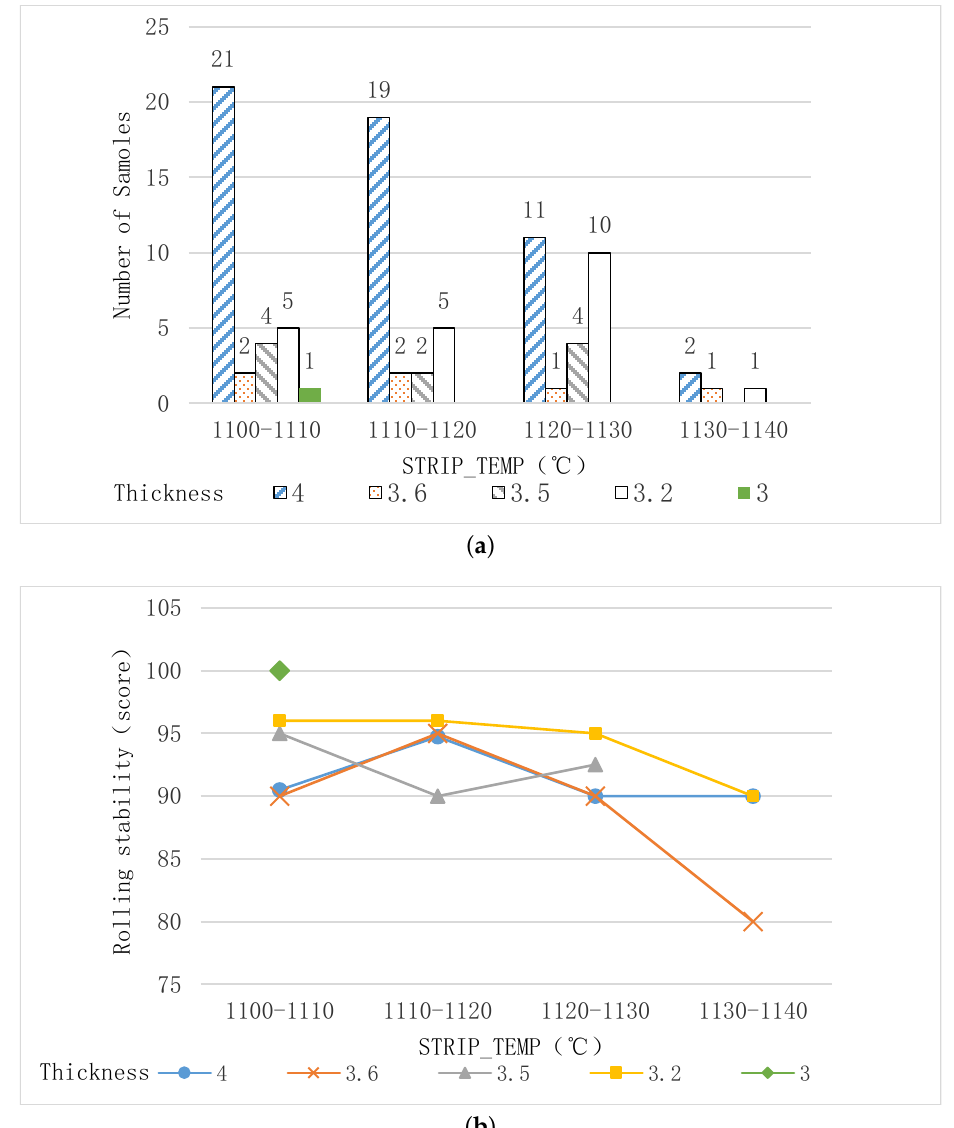
Figure 8. Finishing temperature. ( a ) Sample distribution; ( b ) Stability